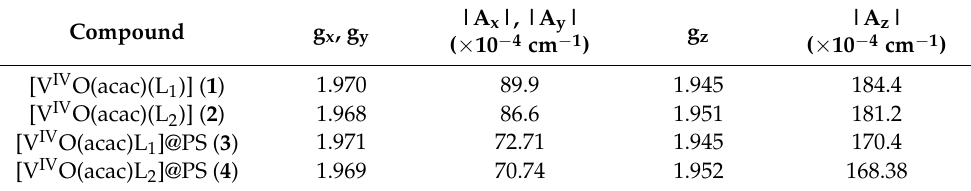
Figure 12. X-band EPR spectra of ( a ) complex 1 , ( b ) complex 2 , ( c ) complex 3 and ( d ) complex 4 recorded in DMSO at 100 K. Table 2. Spin Hamiltonian Parameters Obtained from the EPR Spectra of Complexes 1 , 2 , 3 and 4 Recorded in DMSO at 100 K.